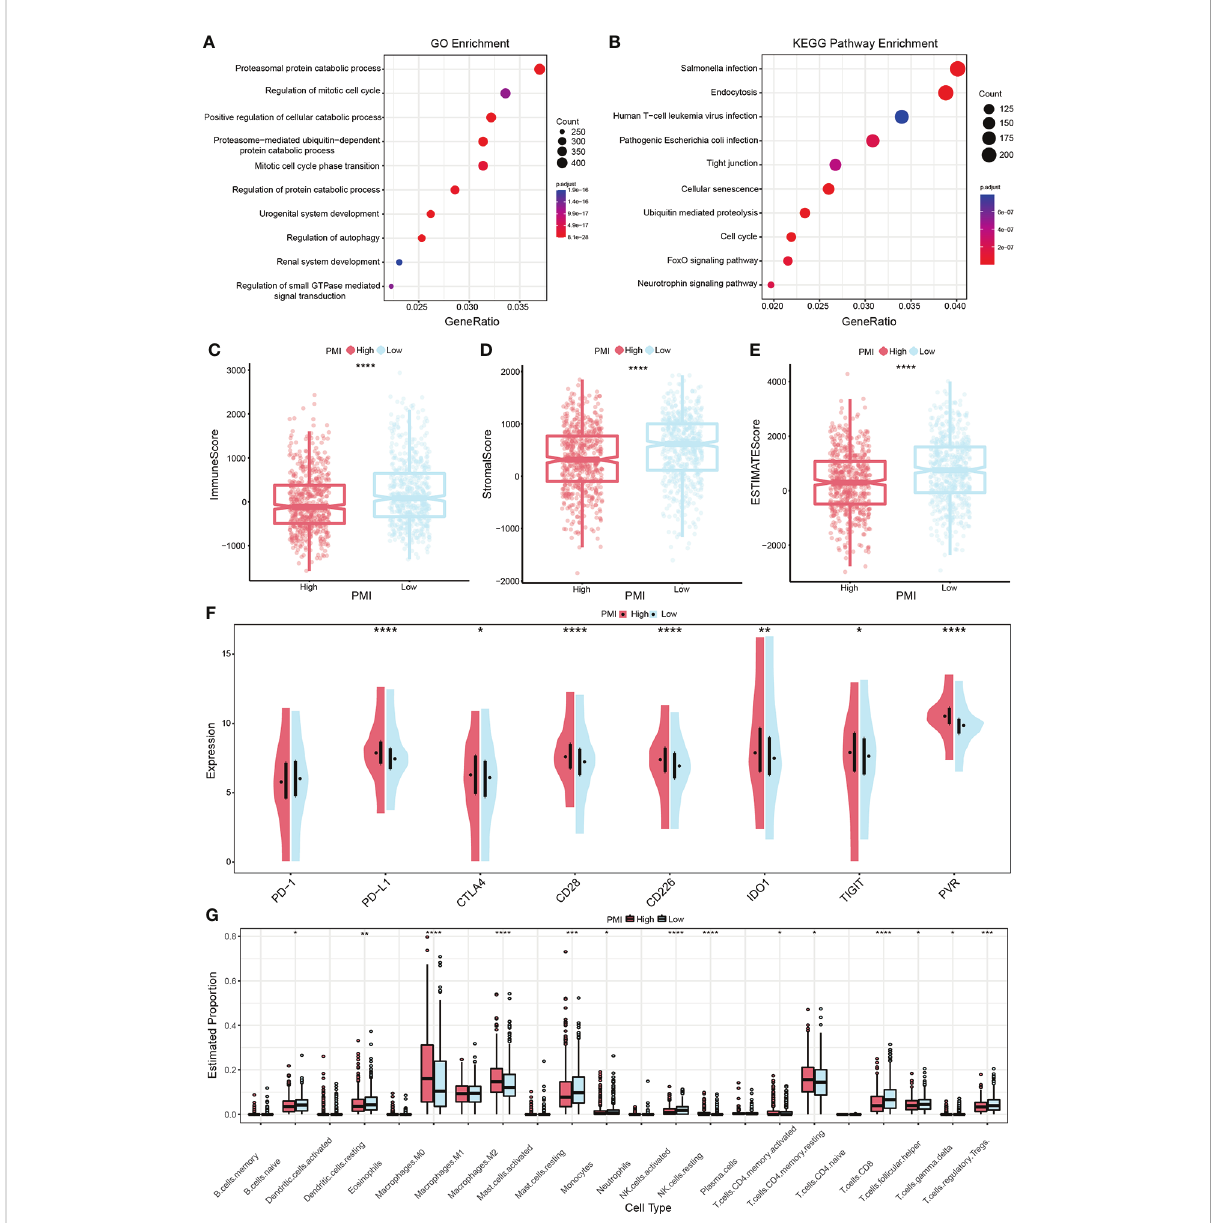
FIGURE 9 PMI-based GSEA enrichment analysis and TME assessment in BC. (A, B) Presentation of the top 10 differential pathways from GO (A) and KEGG (B) enrichment analysis results in TCGA-BRCA. (C – E) Variance of immune score (C) , stromal score (D) , and ESTIMATE score (E) in different PMI groups. (F) Differences in the mRNA expression levels of eight well-known immune checkpoints between different PMI groups. (G) Boxplots were used to depict the discrepancies in the in fi ltration extent of 22 immune cells between different PMI groups among BC patients. *p< 0.05; **p< 0.01; ***p< 0.001; ****p<